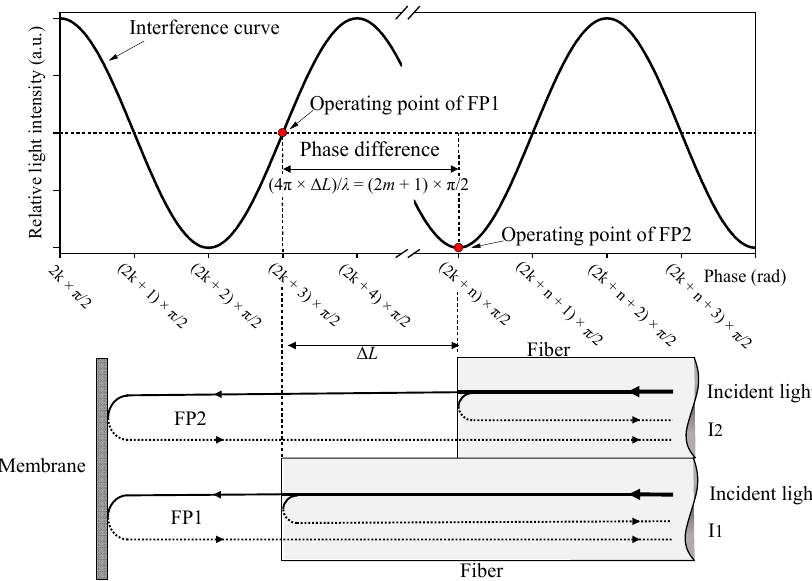
Figure 1. Schematic diagram of the quadrature fiber optic F–P cavity microphone.